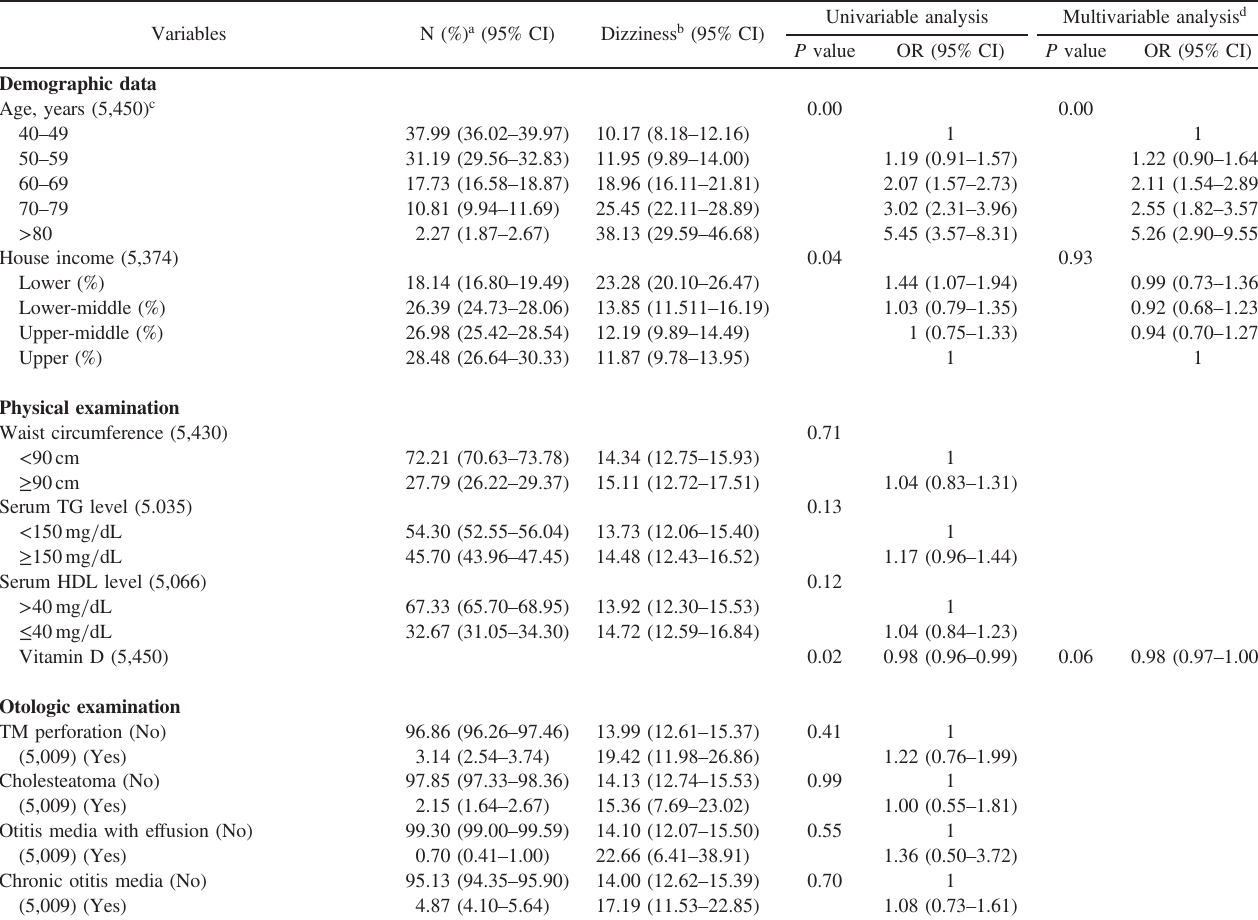
Table 2. Analysis of associated factors in men over 40 years old ( n =